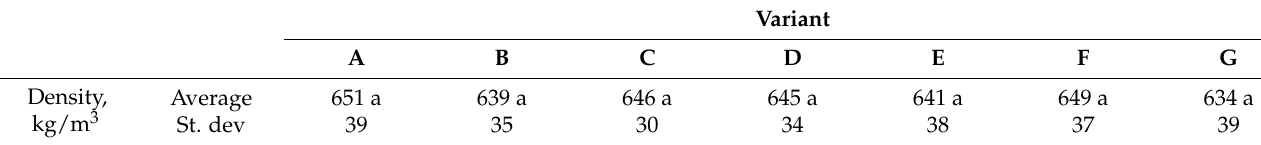
Table 3. The average density of manufactured particleboards.